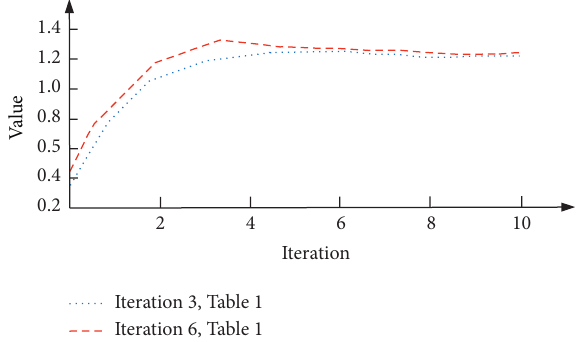
Figure 5: Convergence of two independent groups of SWSO